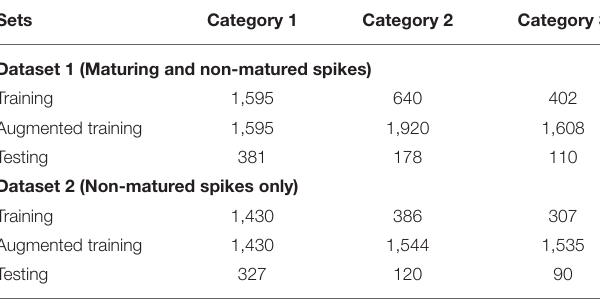
TABLE 1 | Training and testing data distribution and the number of images used in Dataset 1 and Dataset